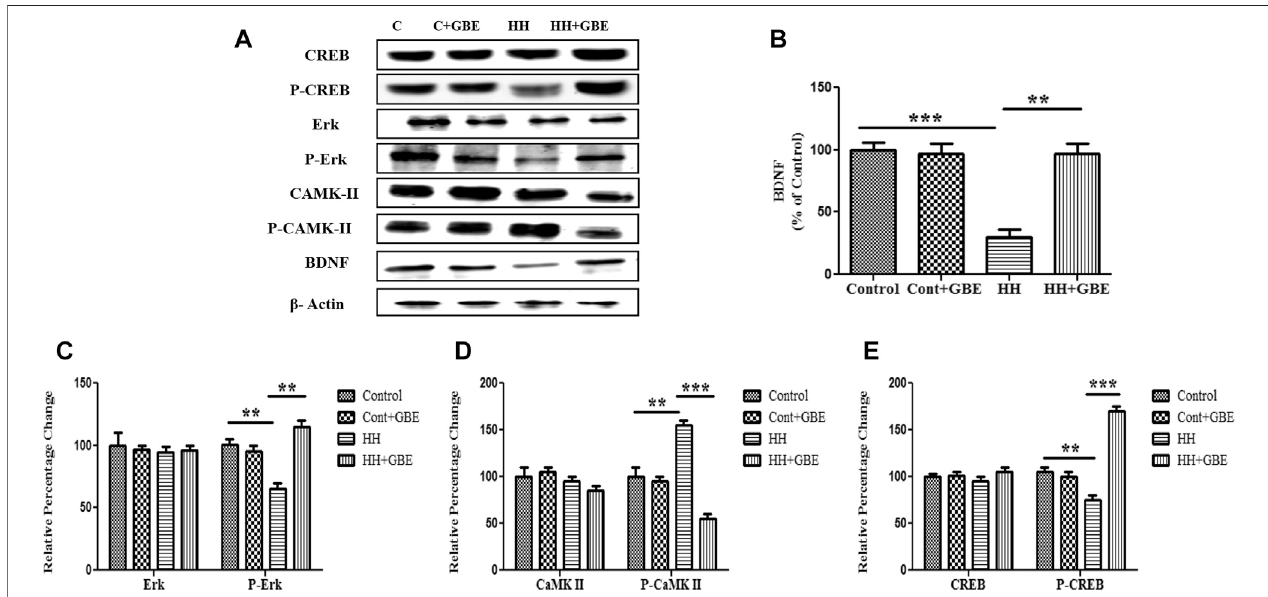
FIGURE 8 | GBE activates the ERK/CaMKII/CREB pathway. Immunoblot of CREB, p-CREB, ERK, p-ERK, CaMKII, p-CaMKII, and BDNF proteins (A) . Further densitometry analysis of respective immunoblots was performed through ImageJ software and represented as a bar graph of BDNF (B) p-ERK (C) , p-CaMKII (D) , and p-CREB (E) . No signi fi cant changes were observed in ERK, CaMKII, and CREB expressions. One-way ANOVA with the Bonferroni test was used to analyze the data. Data are represented as mean ± SEM. * p < 0.05, ** p < 0.01, and *** p <